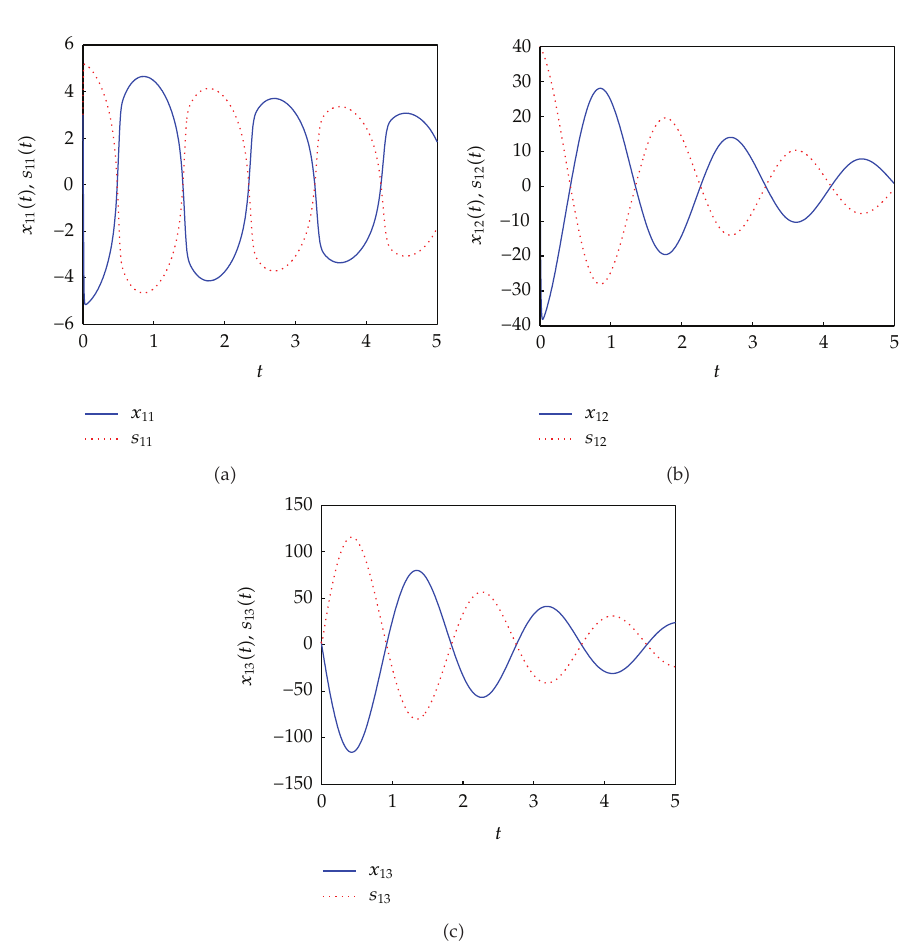
Figure 1: The trajectories of nodes in the first